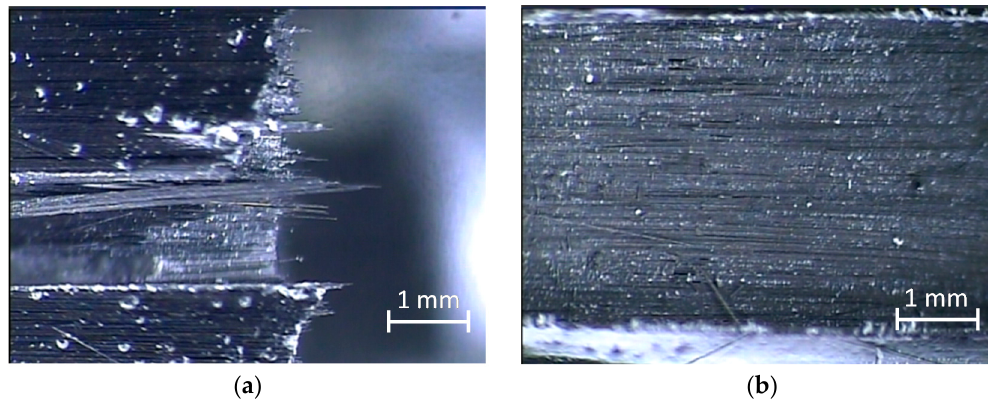
Figure 13. Typical failure mode of loaded steel/CFRP DSJs subjected to quasi-static tensile loading; ( a ) CFRP rupture; ( b ) CFRP delamination.